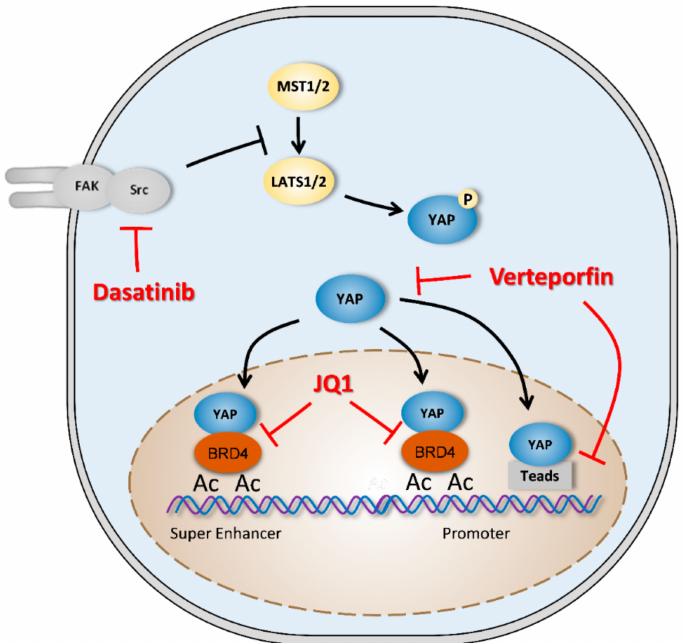
Figure 4. YAP drug targets. Verteporfin blocks YAP (yes-associated protein) signaling pathway either by decreasing YAP expression or by inhibiting YAP–TEAD (transcriptional enhanced associate domain) interactions. Dasatinid decreases LATS1 / 2 (large tumor suppressor 1 / 2) phosphorylation and activity driven by Src activity. JQ1 blocks YAP driven BRD4 (bromodomain-containing protein 4) activity by inhibiting BRD4 association to chromatin (Ac: